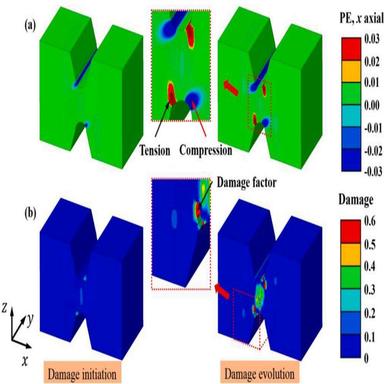
Crack initiation and evolution of the PMI foam specimens under pure shear loading. (a) Plastic strain component along the x axial; (b) damage initiation criteria during shearing process. The crack started in the gauge segment of the V-notched specimen and propagated in minimum energy path, which was the same as observed in experiment.